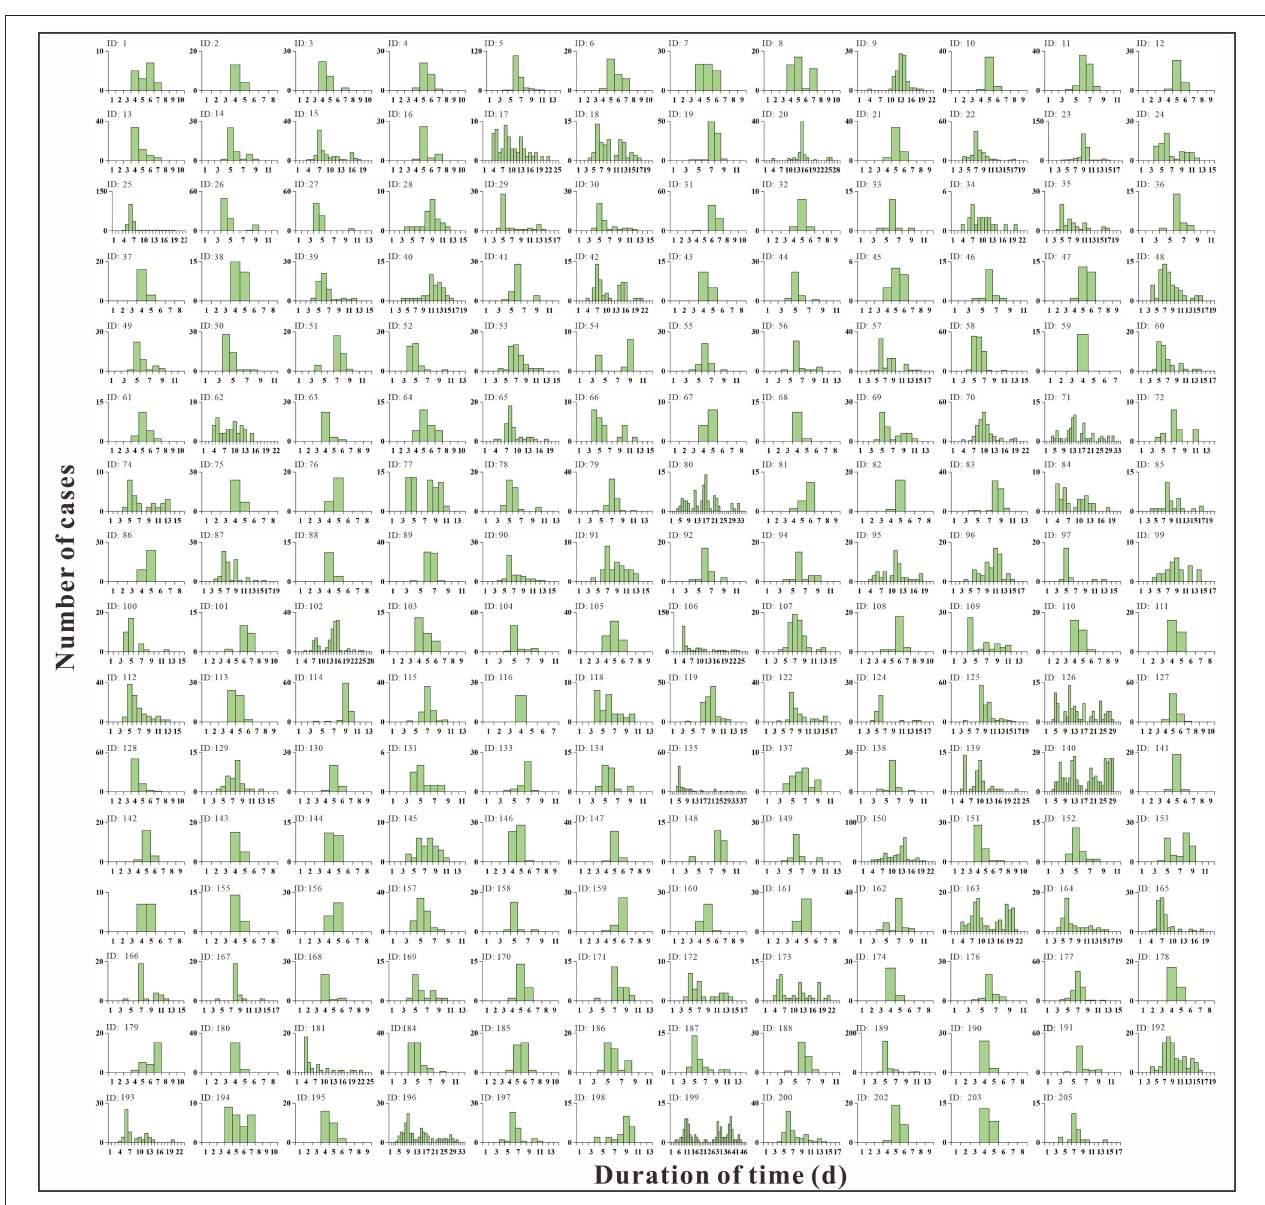
FIGURE 3 | Epidemic curve of 206